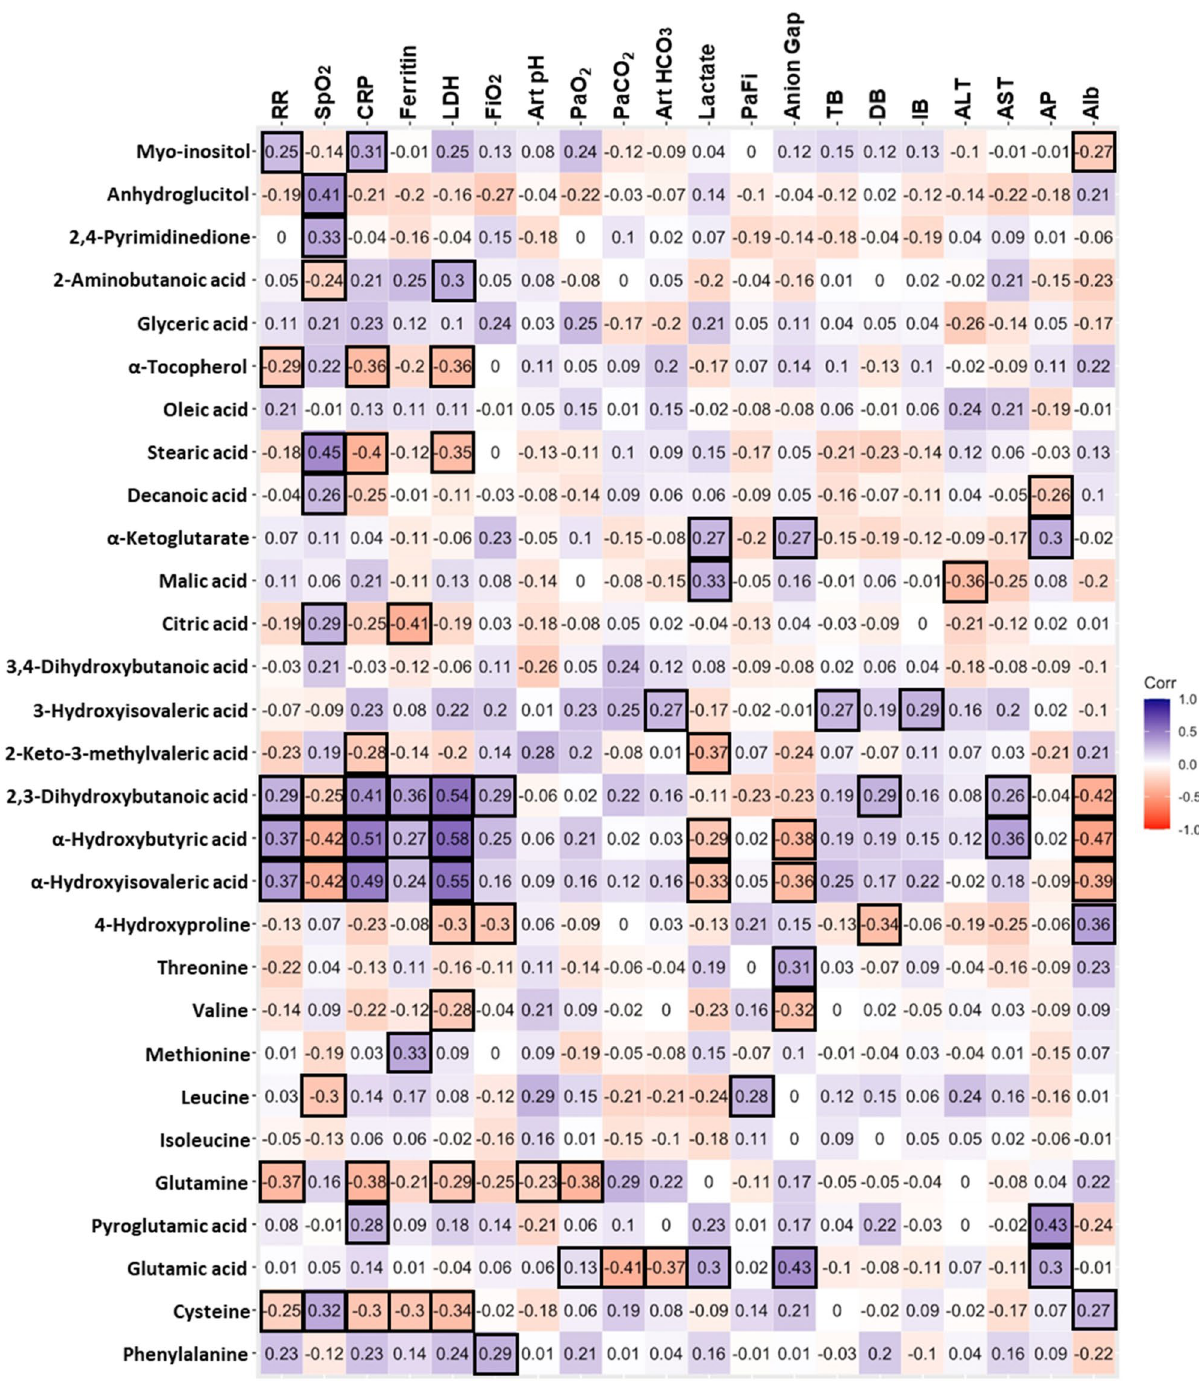
Figure 3. Spearman’s correlation analysis. Correlation analysis of the modified metabolites in severe COVID- 19 patients and the clinical parameters considered. Blue numbers indicate a positive association. Red numbers denote a negative association. Squared values denote associations with values p < 0.05. RR = Respiratory rate, SpO 2 = Oxygen saturation, LDH = Lactate dehydrogenase, FiO 2 = Fraction of inspired oxygen, Art pH = Arterial pH, PaO 2 = Partial pressure of oxygen, PaCO 2 = Partial pressure of CO 2 , Art HCO 3 = Arterial bicarbonate, PaFi = PaO 2 / FiO 2 , TB = Total bilirubin, DB = Direct bilirubin, IB = Indirect bilirubin, ALT = Alanine aminotransferase, AST = Aspartate aminotransferase, AP = Alkaline phosphatase, Alb = Albumin. Exact p values are referred in Supplemental Table